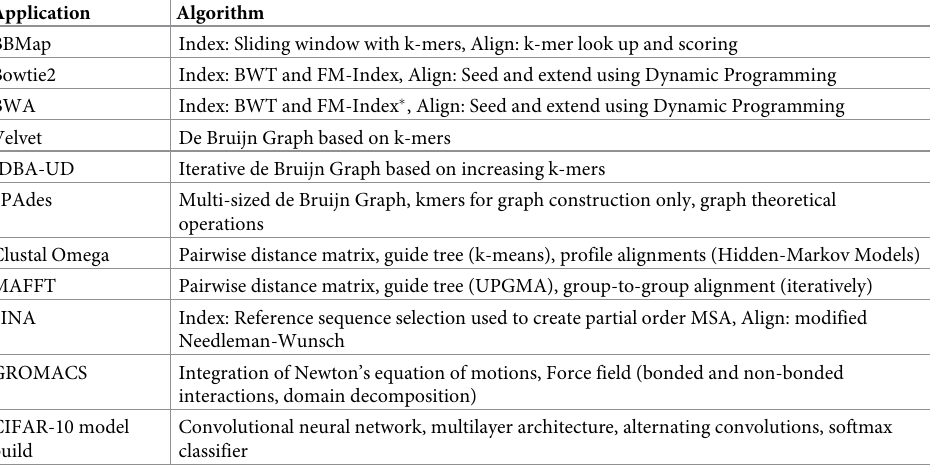
Table 2. List of used benchmark tools. The algorithm column describes in brief the used algorithms to allow a com- parison among each other ( � No parallelization). Application Algorithm